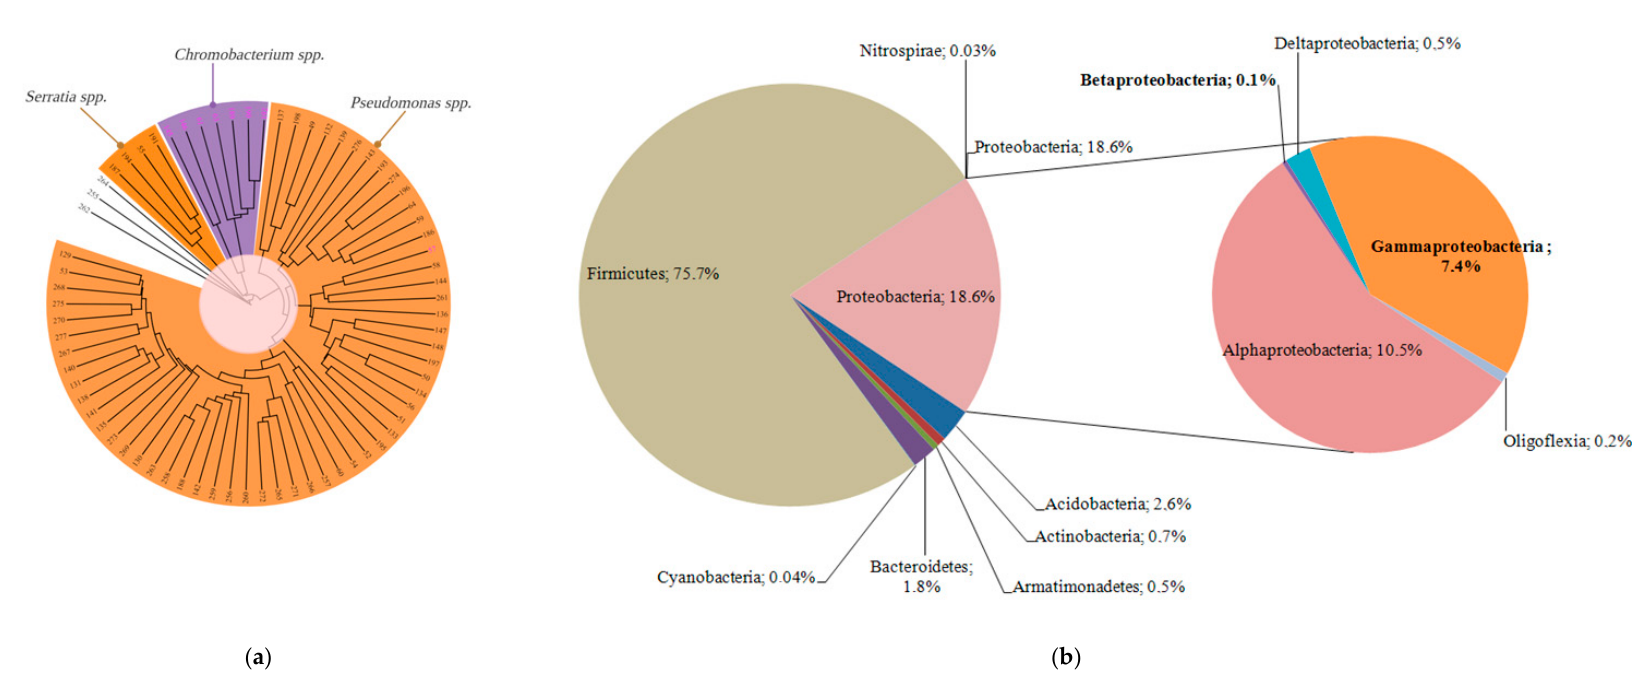
Figure 7. Surrounding bacterial community in biofilm. ( a ) Culturome of root-associated biofilm obtained through IDBac fingerprint grouping. Numbers represent the colony identification number on plates. Mixed species colonies excluded from analysis; ( b ) Proportion of different bacterial taxonomic groups in 16S rDNA microbiome of the root-associated biofilm. Inset in the diagram reveals the phylum of Proteobacteria.